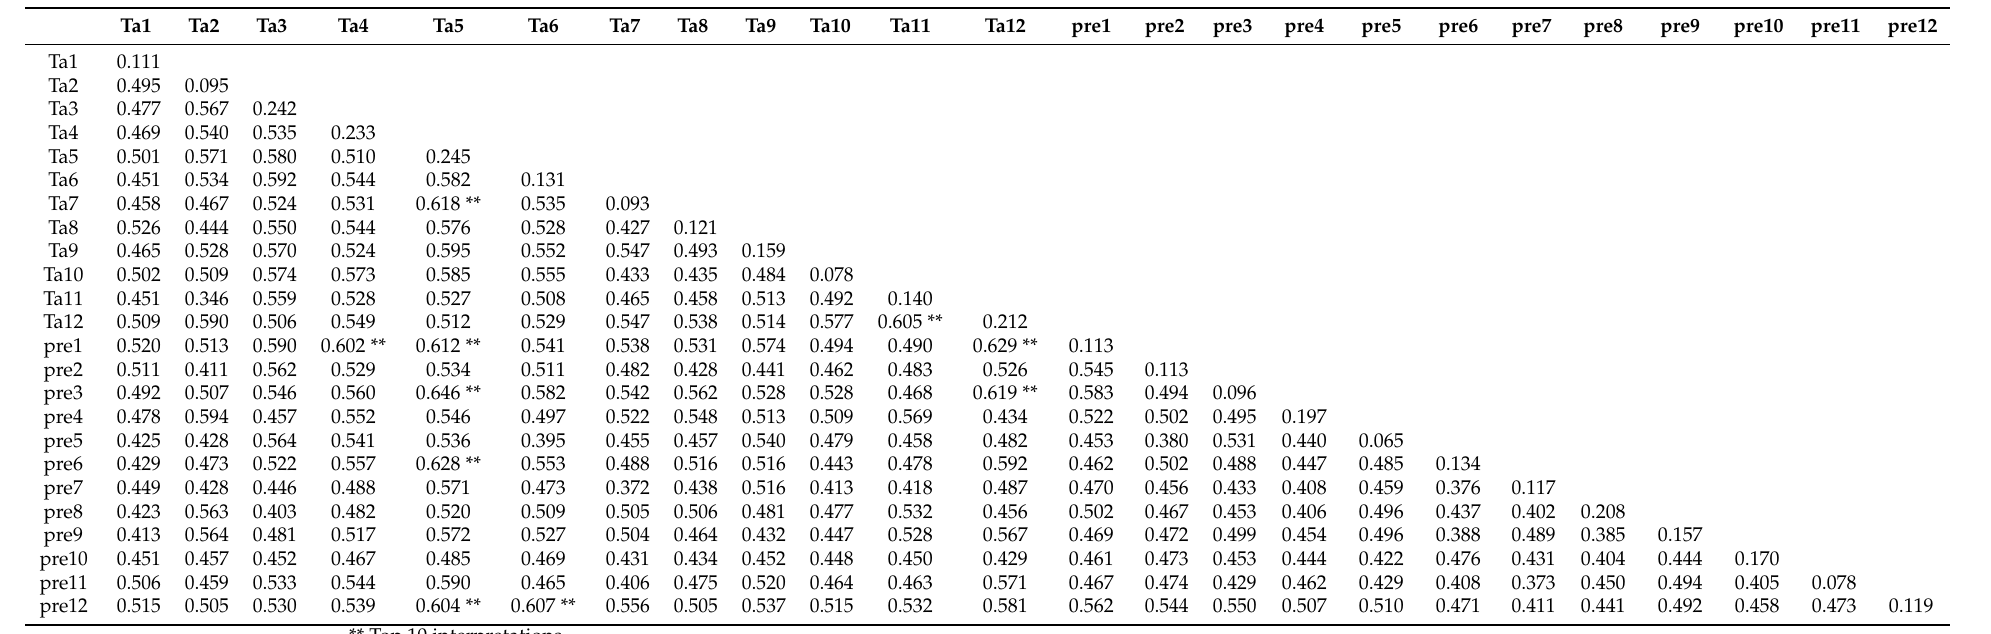
Table A1. Interpretation of SOS changes by multi-element